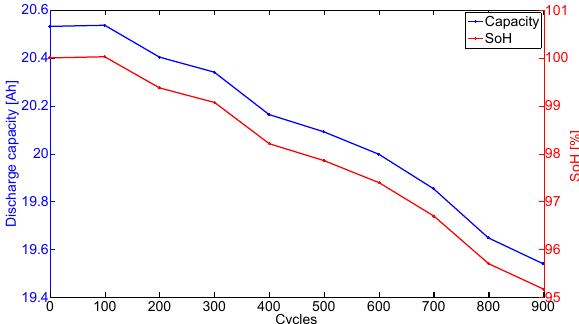
Figure 1. Evolution of the discharge capacity and the State-of-Health (SoH) of the cell 2 with the number of cycles.